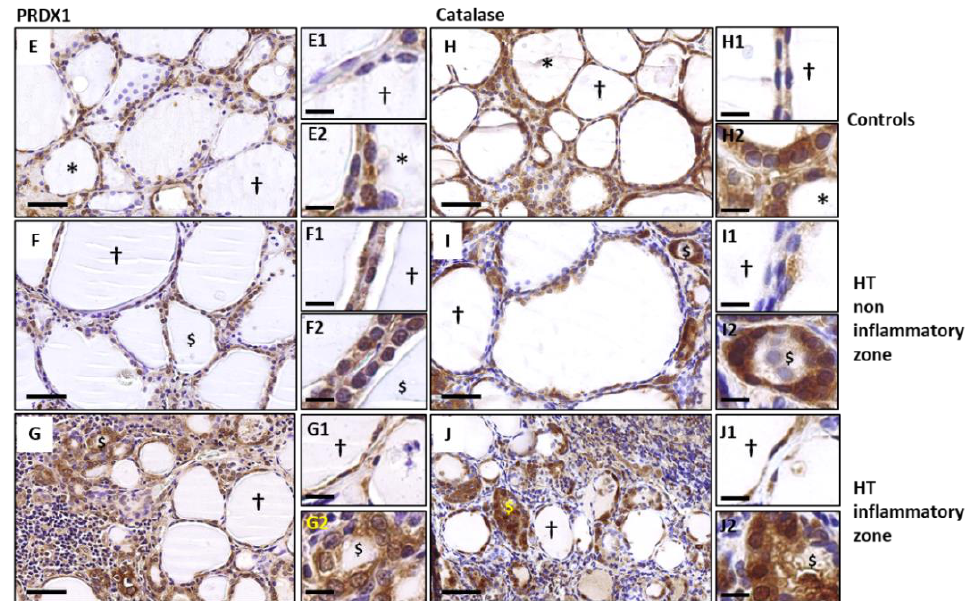
Figure 3. Antioxidant proteins, PRDX1, and catalase, were decreased by Th1 cytokines and catalase was significantly decreased in thyroid samples. PRDX1 and catalase protein expression were quantified by Western blot technique. Primary cultures of human thyrocytes treated with Th1 cytokines had significantly reduced PRDX1 ( A ) and catalase ( B ) expression. Densitometric values were normalized against the β-actin level. Results are expressed as means ± SEM from three experiments ( n = 3) at least in duplicate. In HT thyroid samples, PRDX1 protein expression ( C ) was unchanged as compared to controls, while catalase protein expression ( D ) was significantly reduced. Densitometric values were normalized against GAPDH level. Values are expressed as means ± SEM from five or six individual samples ( n = 5–6). * p < 0.05, compared to controls. Representative blots are shown. Immunohistochemically stained sections of paranodular tissue from multinodular goiter patients designated as controls ( E , H ) and HT thyroid tissues ( F , G , I,J ). In control glands, hypofunctional follicles (†) expressed low levels of PRDX1 and active follicles (*) showed an increased PRDX1 (E) and catalase ( H ) marking. In HT thyroids, hypofunctional (†) and altered active-like ($) follicles in non- inflammatory zone presented, respectively, no and low staining of PRDX1 ( F ) and of catalase ( I ). In inflammatory zones, active-like follicles ($) strongly expressed PRDX1 ( G ) and catalase ( J ). Illustrated images are representative of both conditions. ( E – J ) Scale bar = 50 µ m. ( E1 – J2 ) Scale bar = 20 µ